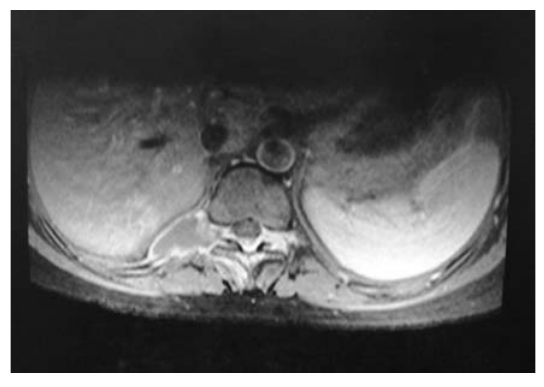
Figure 3. Post contrast T1W axial demonstrates peripherally enhancing right paravertebral lesion with involvement of ipsilateral posterior element, neural foramina and adjacent